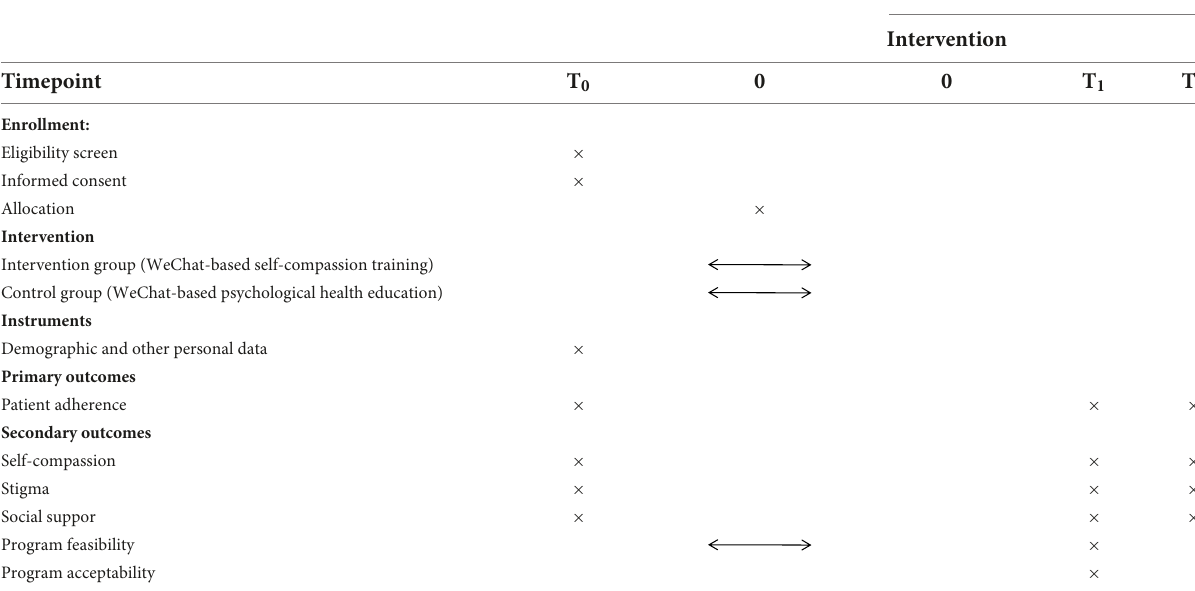
TABLE 2 SPIRIT figure, schedule of enrollment, interventions, and